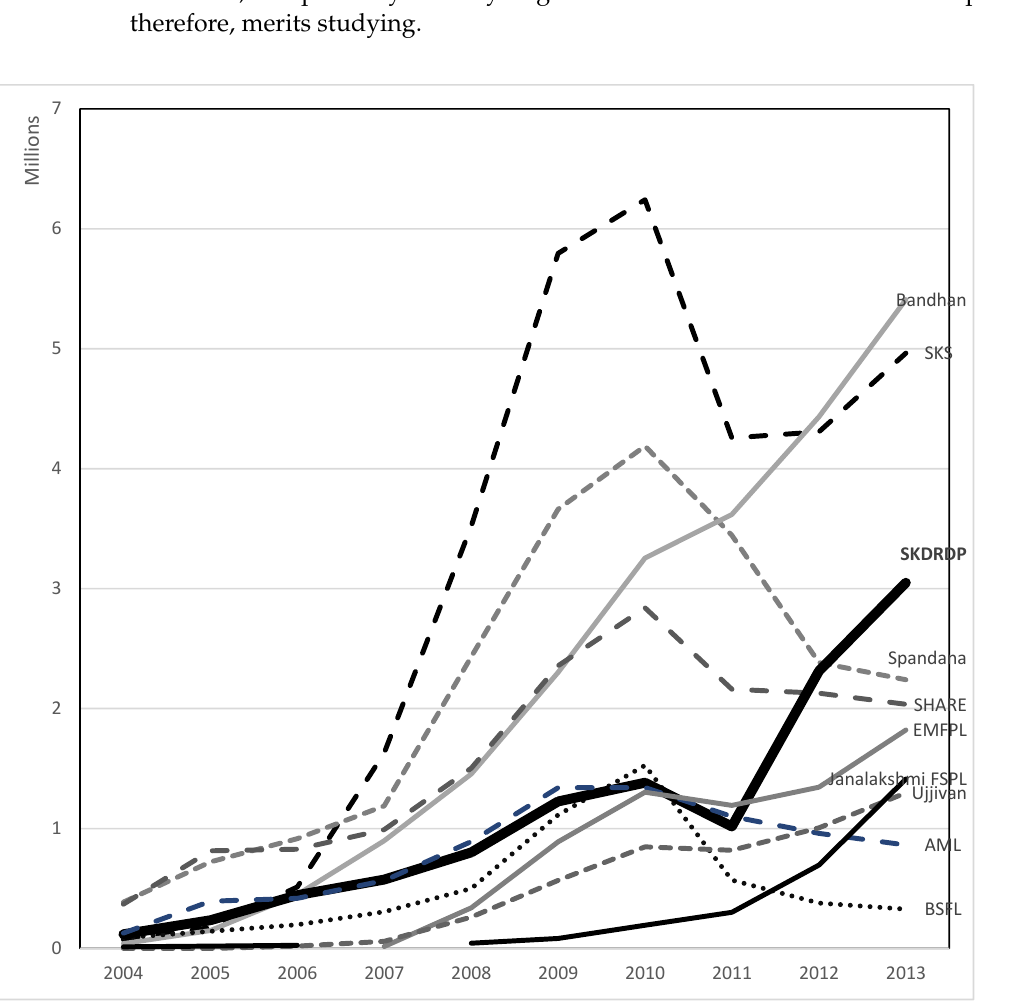
Figure 1. Outreach of Top Indian MFIs. Source: Data downloaded from MIX. Table 1. ROA of Top Indian MFIs.